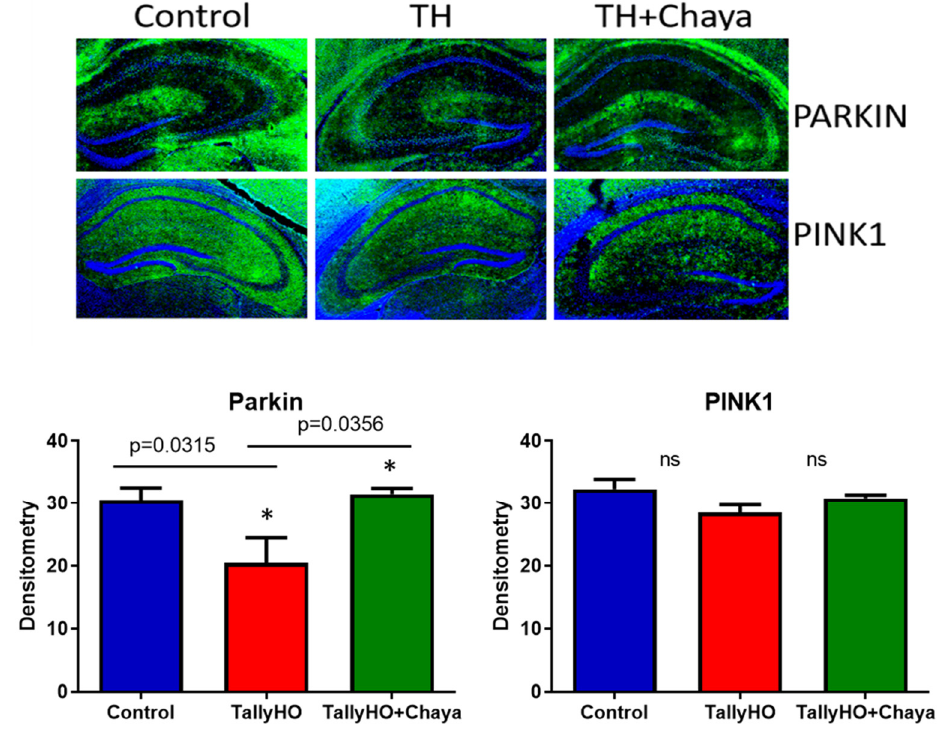
Figure 9. Immunofluorescence analysis of the hippocampal mitochondrial autophagy proteins Parkin and PINK1 of 14-month-old non-diabetic control mice, TH mice fed with chaya, and TH mice fed with regular chow. The TH + chaya mice showed significantly increased levels of Parkin, which was reduced in the TH mice ( p = 0.0356). No significant changes were seen in the levels of PINK1 in TH mice compared to the control and in the TH + chaya chow fed mice compared to the TH mice. * p = 0.01.